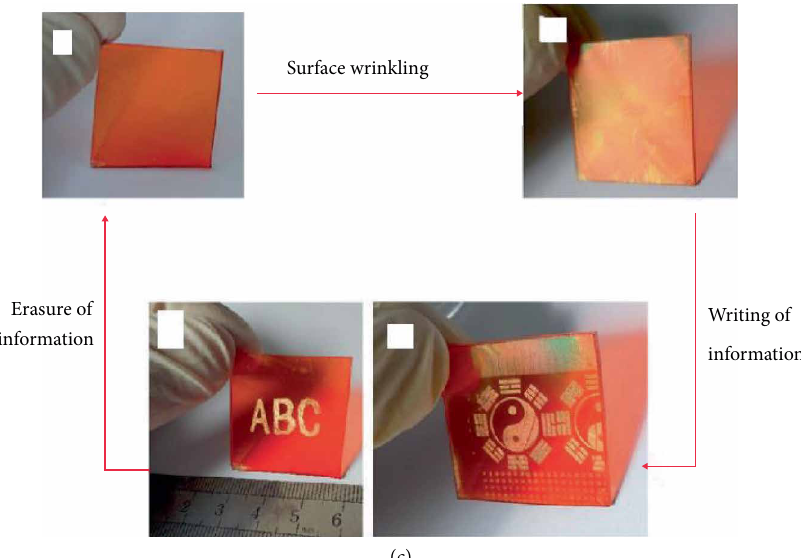
Figure 8: (a) Preparation approaches for the three moisture-responsive wrinkling devices with different responsive dynamics, and the hidden pattern “IMS” could be reversibly revealed by breathing toward the anti-counterfeit tab. Adapted from [184]. (b) Reversible dual-pattern with fluorescence and hierarchical wrinkles obtained through photomasks. Adapted from [187]. (c) Application of the optically erasable wrinkling system for the repetitive optical writing/erasure of information by multiple cycles of stimulus-induced wrinkling, selective exposure, and blanket exposure. Adapted from